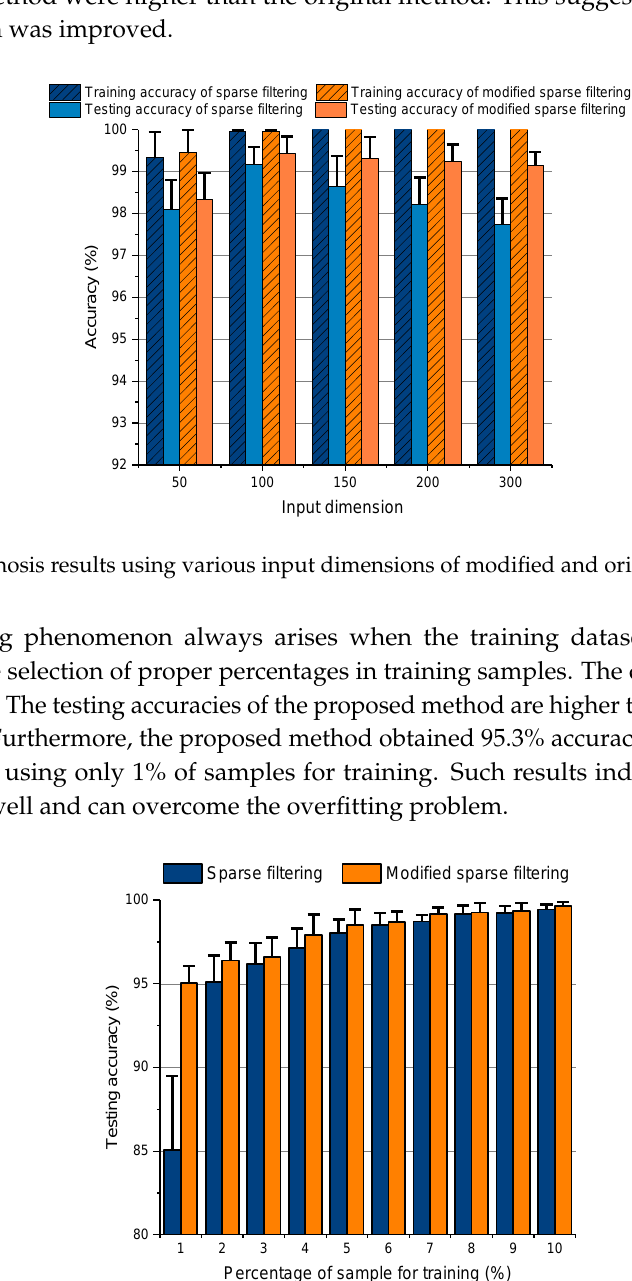
Figure 12. Diagnosis results obtained by different percentages of samples using modified and original sparse filtering.